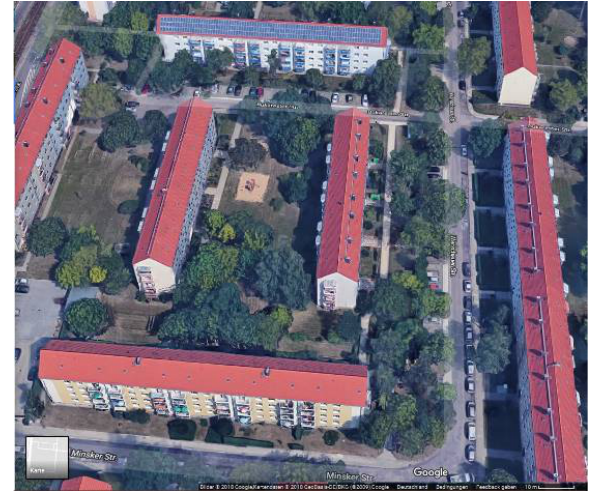
Figure A2. Example of old perimeter development/old buildings with private green space (Google Maps 2018).